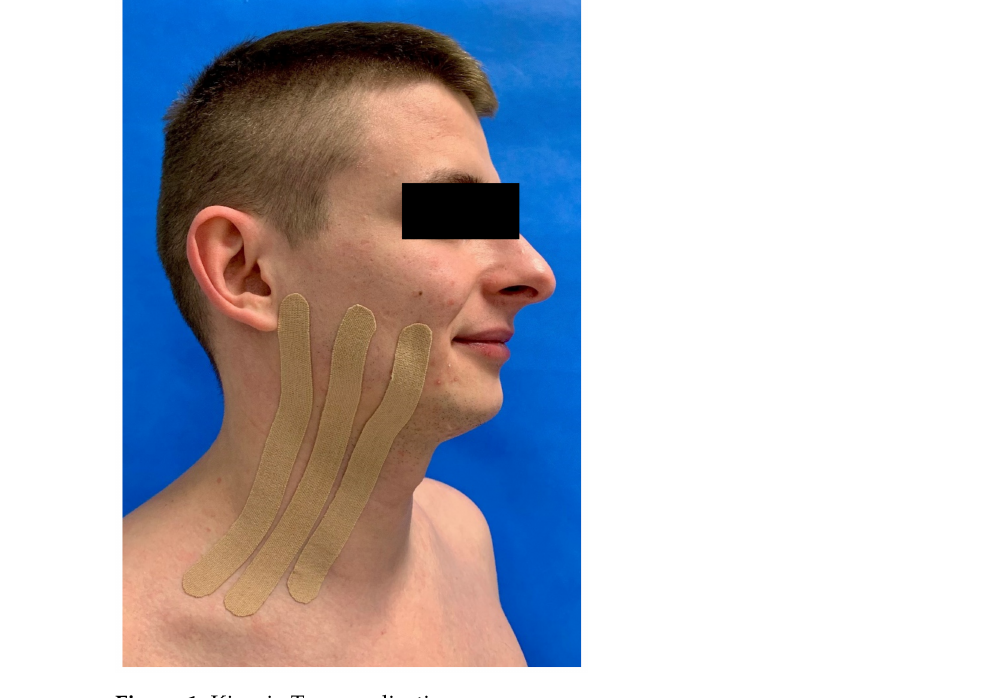
Figure 1. Kinesio Tape application. Table 1. Questionaire’s